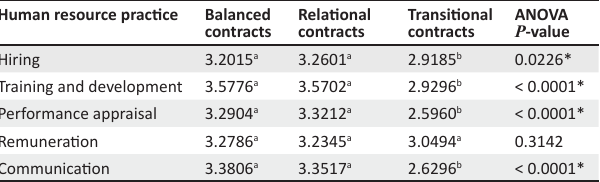
TABLE 11: Relationship between human resource practices and psychological